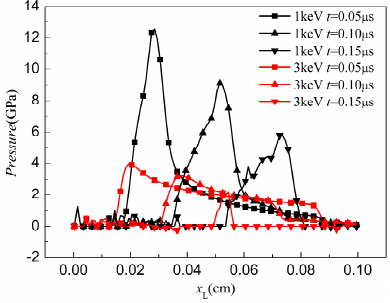
Figure 9. Stress history of CFRP panels.